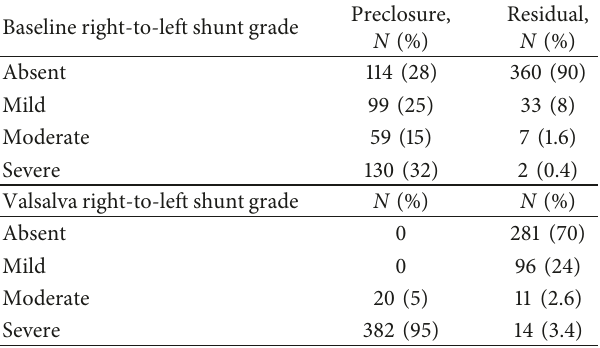
Table 2: Preclosure and residual right-to-left shunt grade at 12- month follow-up ( n � 402).